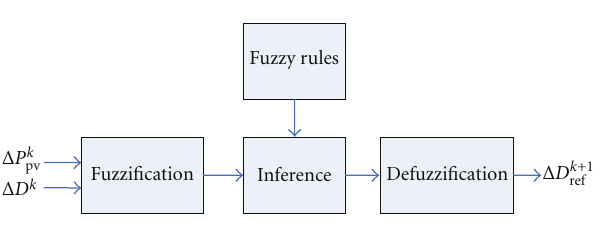
Figure 3: Components of a fuzzy logic controller.